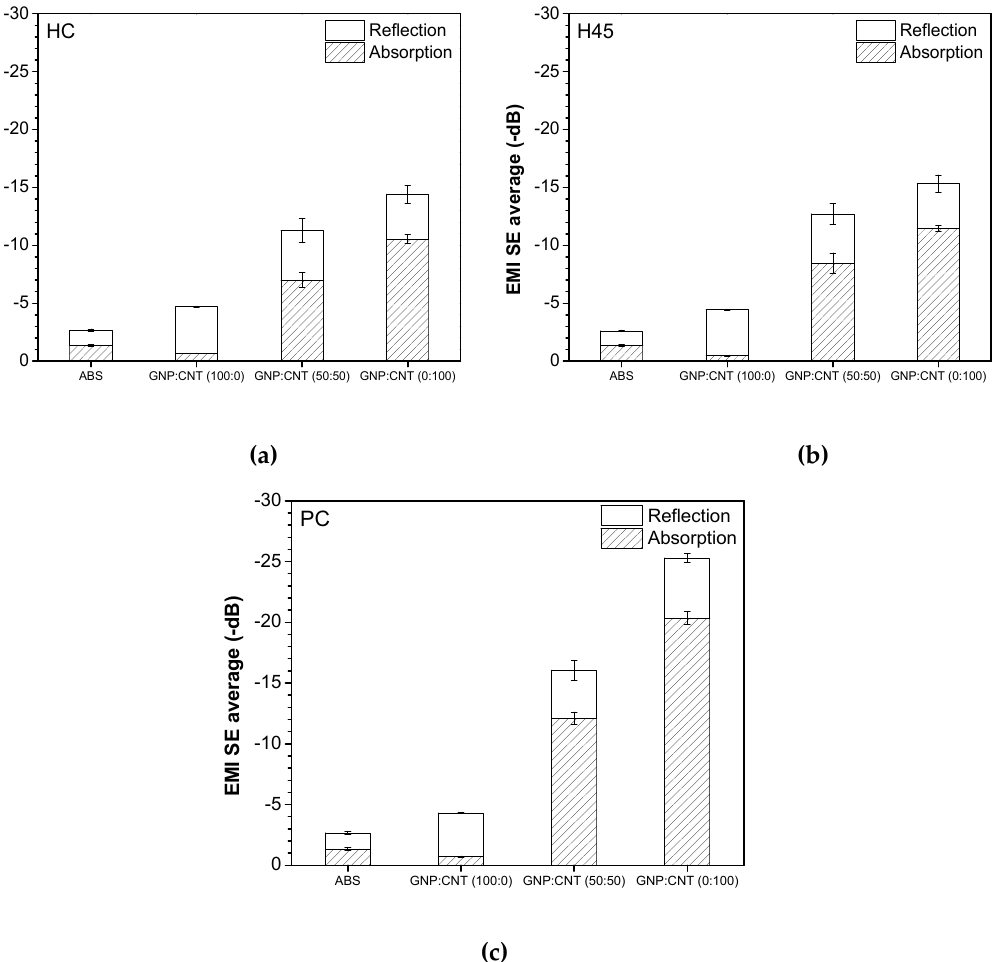
Figure 10. Influence of absorption and reflection mechanisms on the EMI SE of hybrid nanocomposites